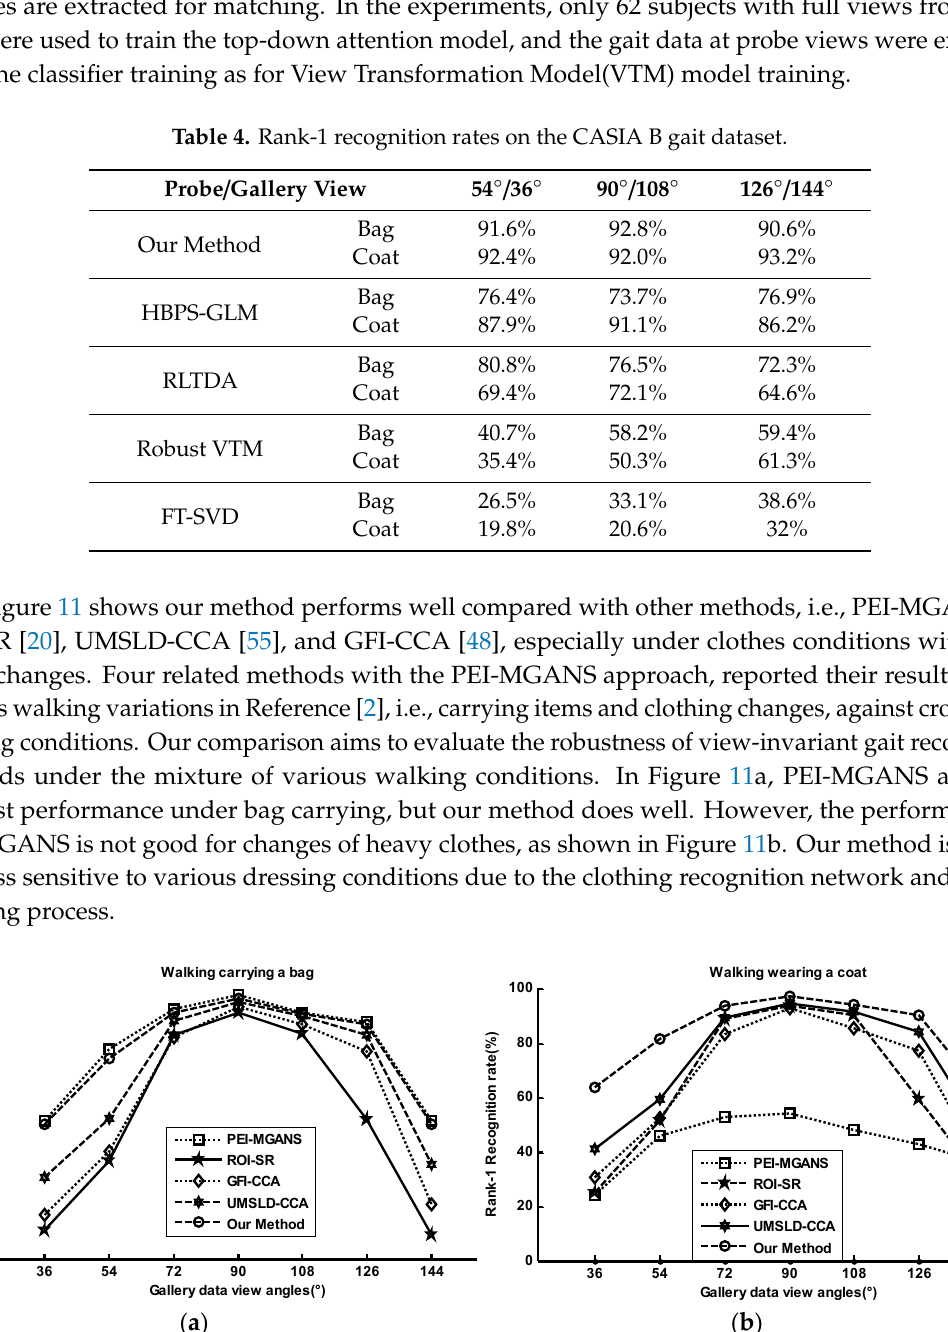
Table 4. Rank-1 recognition rates on the CASIA B gait dataset.